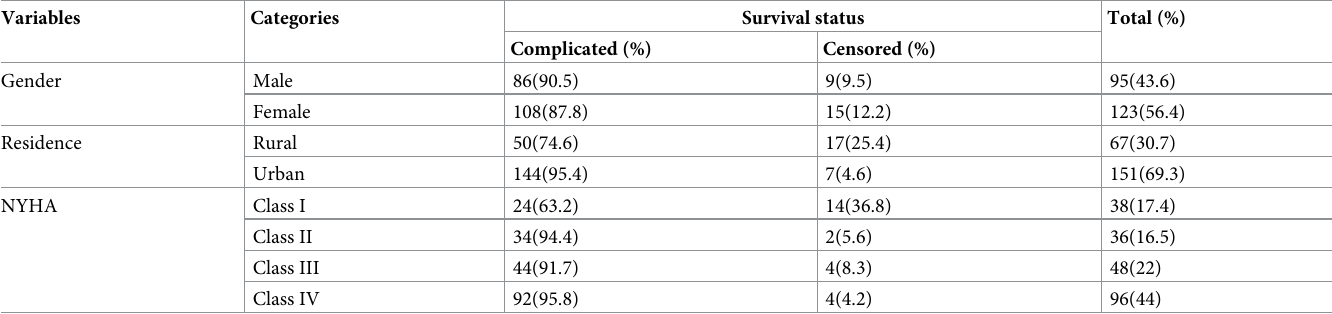
Table 2. Results of the descriptive statistics for categorical